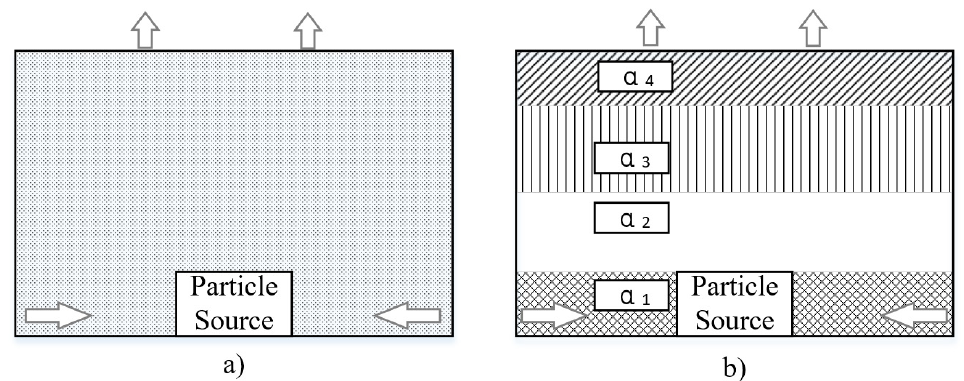
Figure 18. Principle of homogeneous and inhomogeneous particle concentration distribution. ( a ) Homogeneous distribution, and ( b ) inhomogeneous distribution.